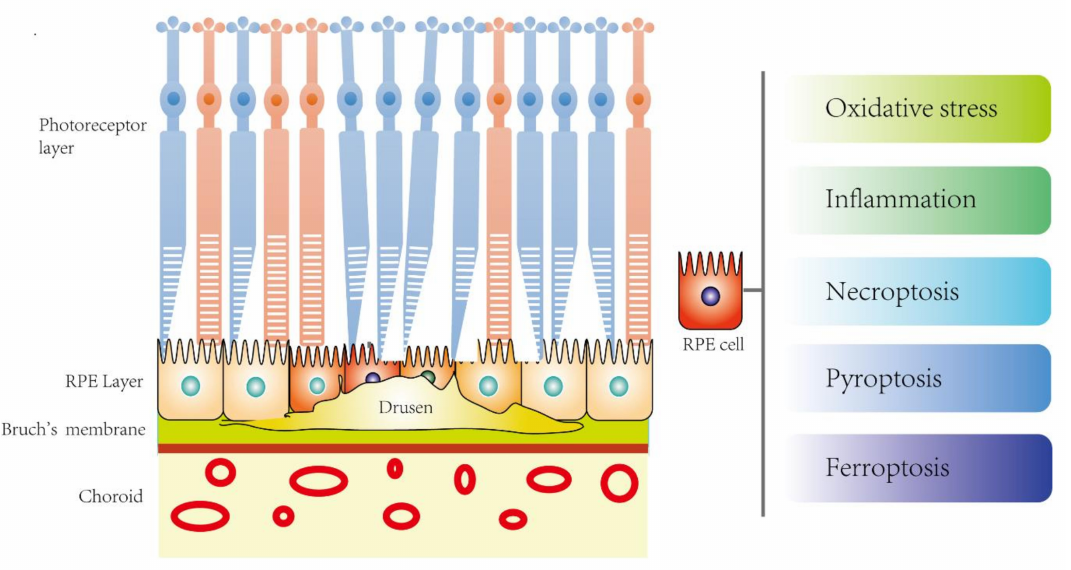
Figure 1. The potential novel disease mechanisms of RPE cell death in age-related macular degeneration